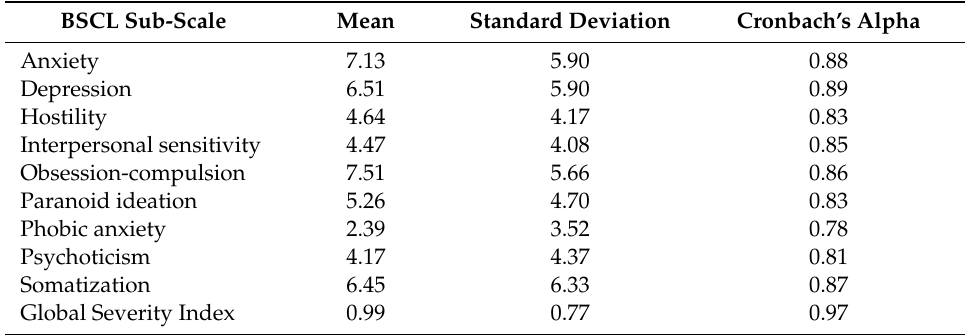
Table 4. Descriptive statistics of the Brief Symptom Checklist (BSCL) questionnaire.